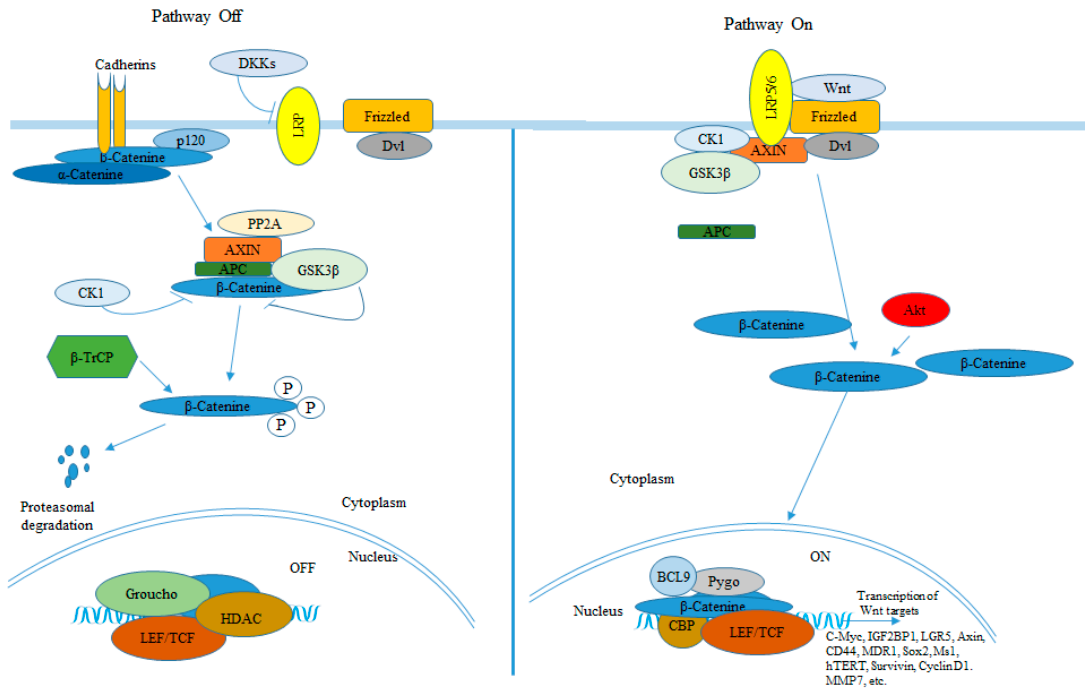
Figure 2. The canonical Wnt/ β -catenin signaling pathway [55–58,60,64,66,68].